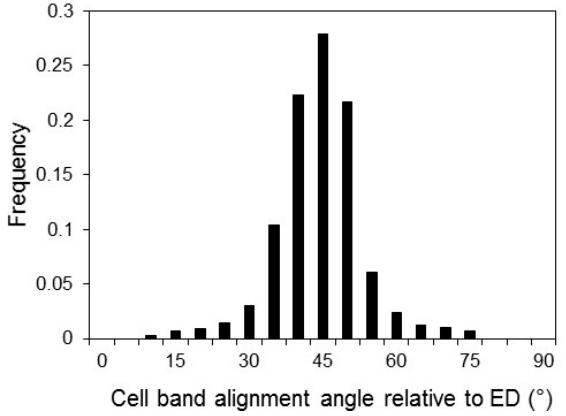
Figure 3. Distribution of cell band alignment angle relative to the extrusion direction (ED), showing that cell bands are substantially aligned with the die shear plane around 45° to ED.